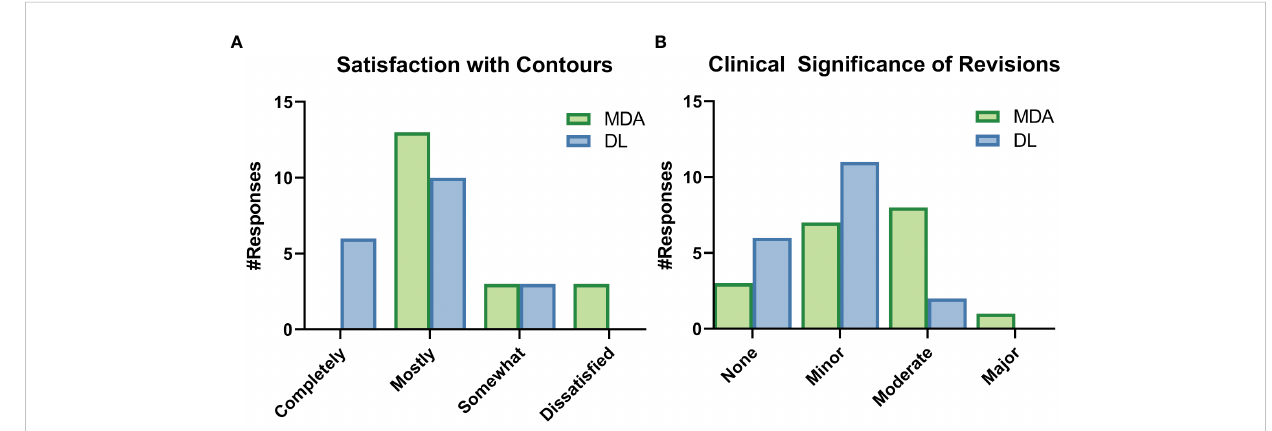
FIGURE 8 Selected results from the survey given to radiation oncologists (ROs) after completion of revision of a particular dataset. These survey questions were asked while the ROs were still blinded to origin of the initial contours, either by a medical dosimetry assistant (MDA) or the deep learning (DL) model. (A) The ROs were asked to rate their satisfaction with the initial contours, as well as (B) rate the clinical signi fi cance of the revisions to the